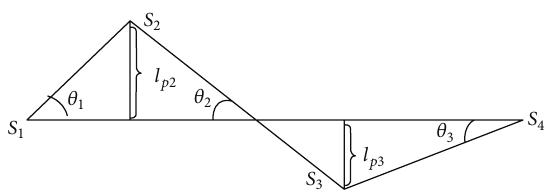
Figure 2: Distance between 3 original lines and one segment that they belong to.